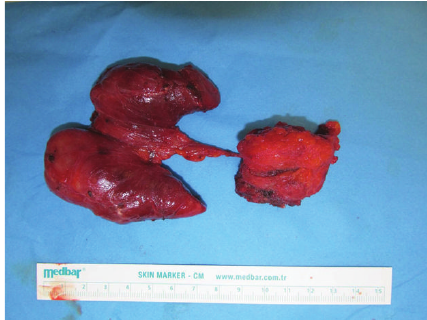
Figure 2: Specimen after total resection of the TDC and thyroidec- tomy with suspected papillary thyroid